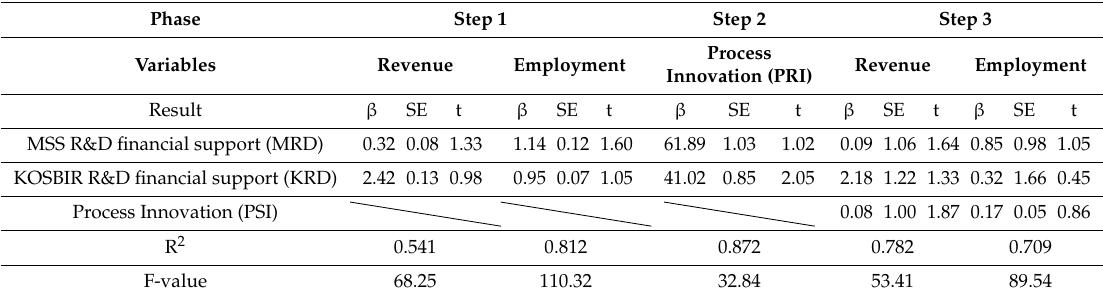
Table 4. Factors a ff ecting increase on business performance and mediating e ff ect of PRI.